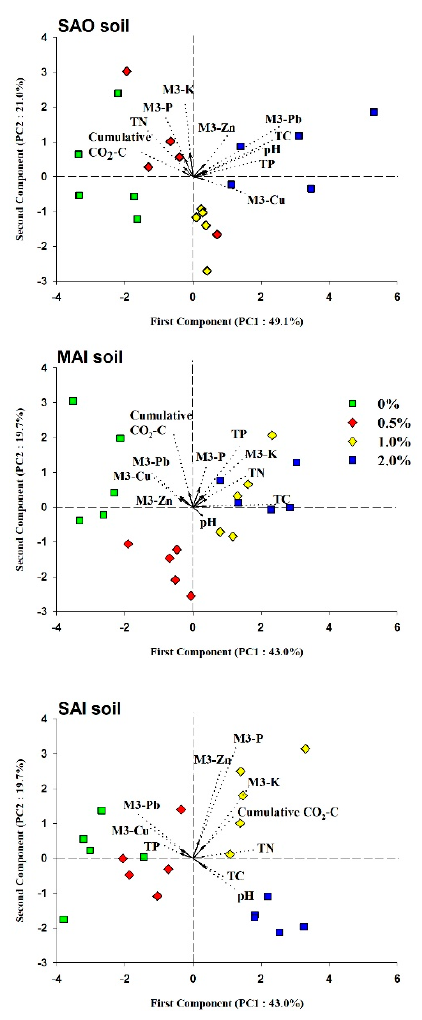
Figure 2. Principal component analysis based on soil chemical characteristics and cumulative CO 2 -C (mg CO 2 -C / 100g soil) after 434-d incubation period in SAO, MAI, and SAI soils treated with 0%, 0.5%, 1.0%, and 2.0% woody BC.